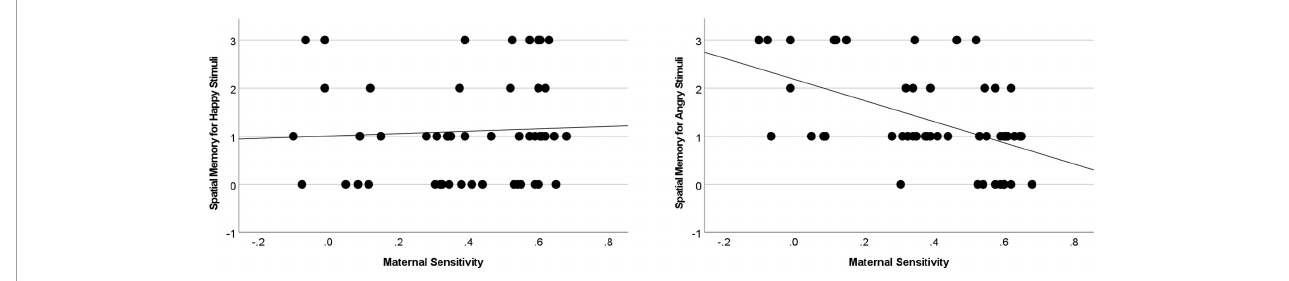
FIGURE2 Insensitive caregiving predicted the difference between Angry and Happy memory during the item-space condition ( B = 2.451, se = 0.969, p = 0.014, 95% CI [0.572, 4.340]), as well as memory for Angry (but not Happy) items [ B = –2.203, se = 0.551, p < 0.001, 95% CI (–3.264,–1.094)].